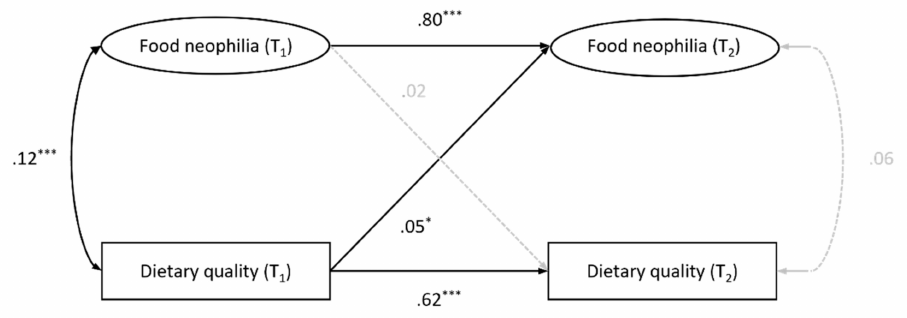
Figure 1. Temporal stability and reciprocal effects of food neophilia and dietary quality ( N = 960). Standardized path coefficients are reported, controlled for gender, age, BMI, educational status, and stringency of government containment policies at T2. Dotted, gray lines indicate non-significant results ( p > .05). * p < .05. *** p < .001.